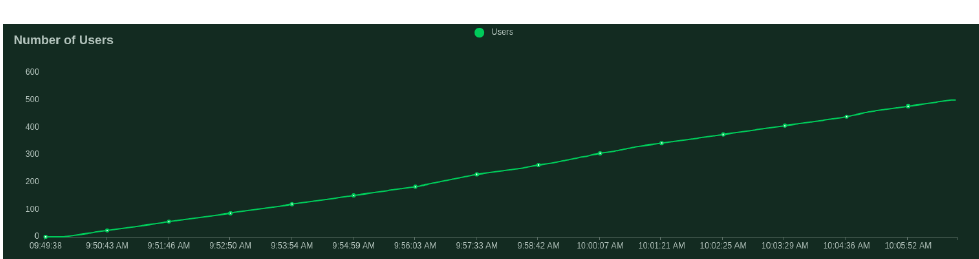
Figure 3. Number of users tested for the validation